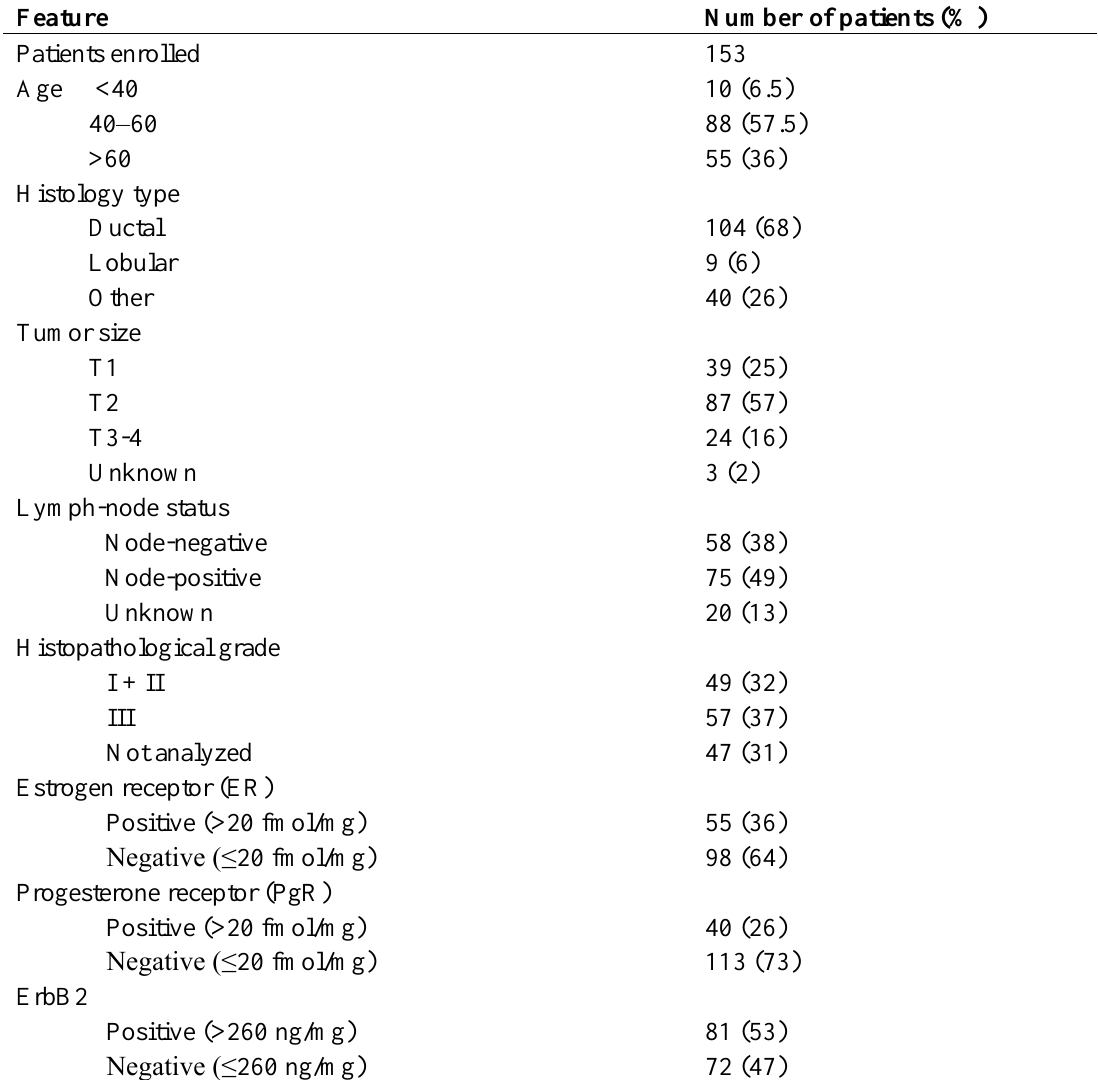
Table 2. Clinicopathological characteristics of the